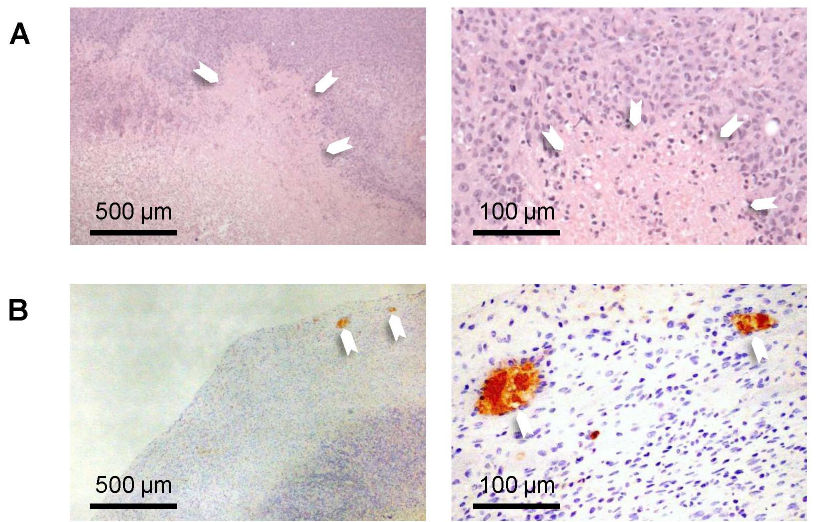
Figure 5. Histology. (A) H&E sections reveal poorly differentiated tumor cells and necrotic areas that are partially or completely devoid of cells (arrowheads). (B) CD34 sections show very low vascularity, with blood vessels (arrowheads) confined to the tumor rim. Magnification is 6 4 (left column) and 6 20 (right column).